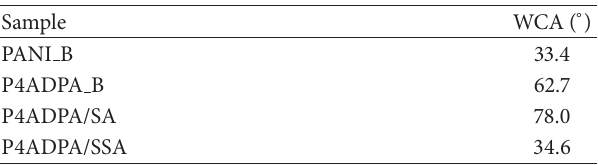
Table 2: Equilibrium values of contact angle measured on PANI